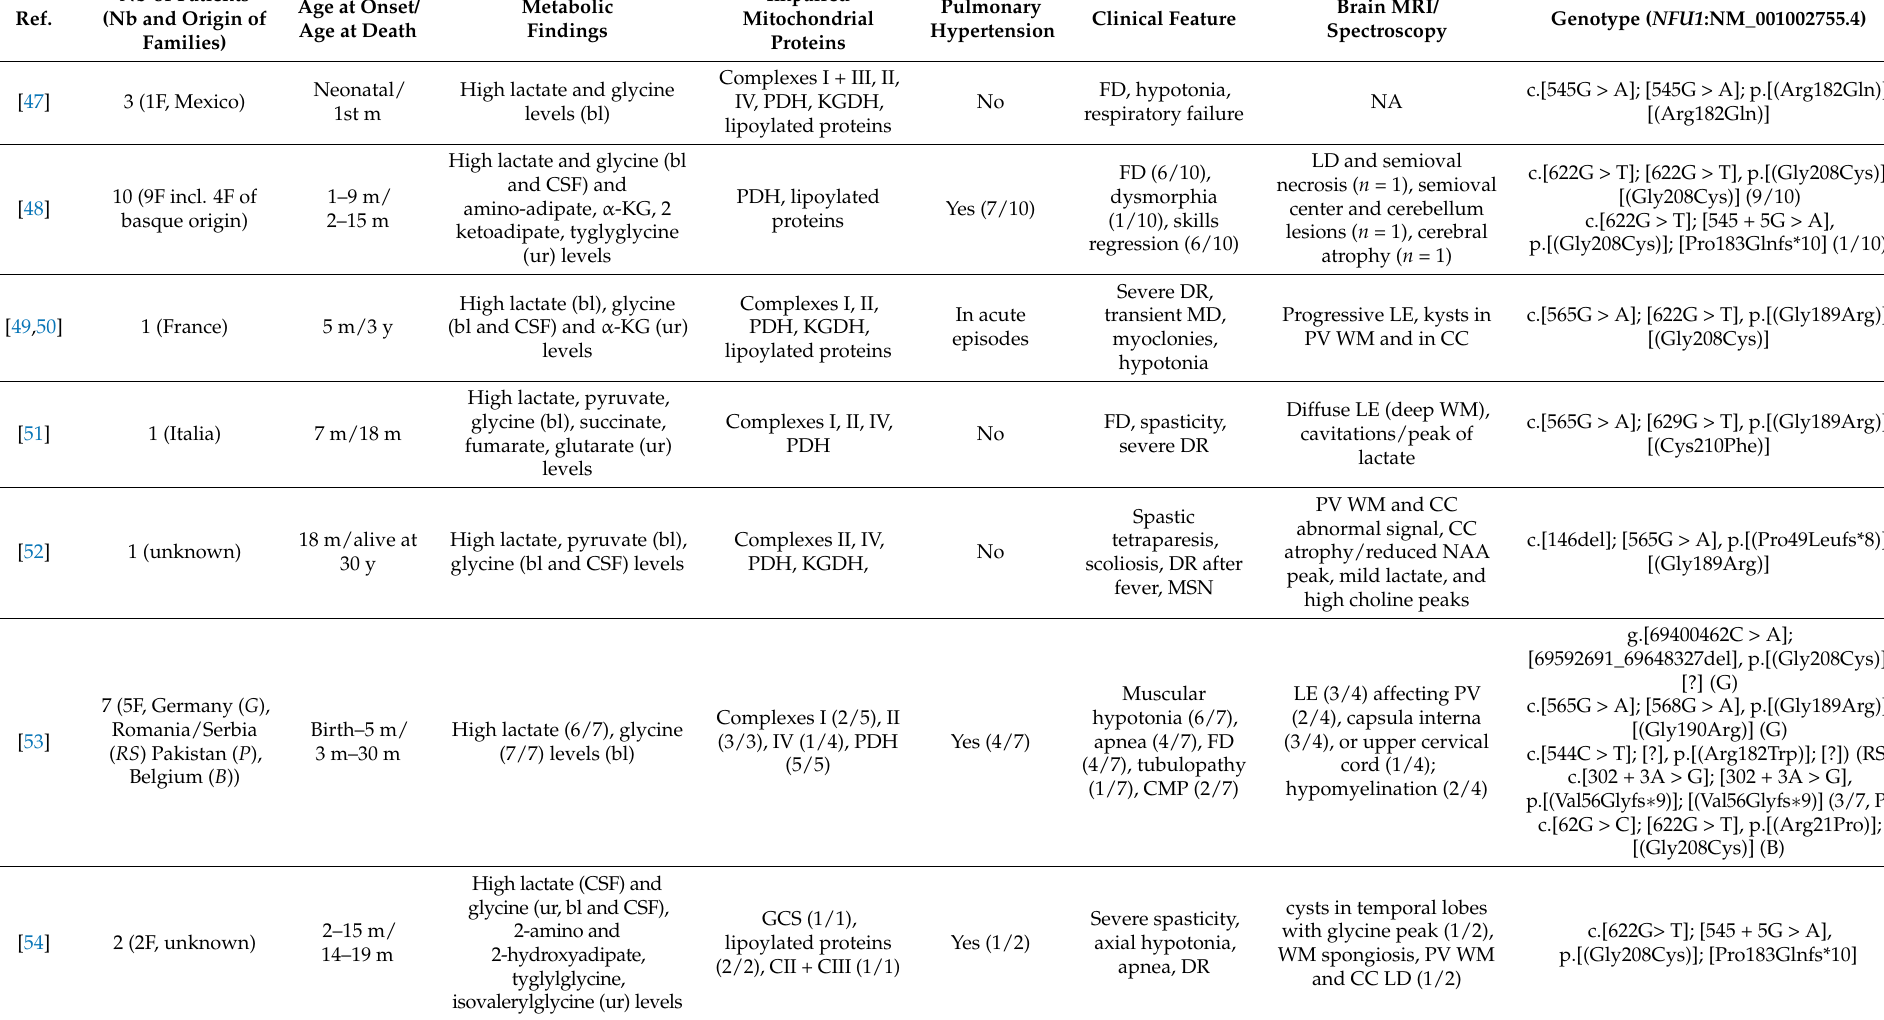
Table 1. Reported patients with MMDS type